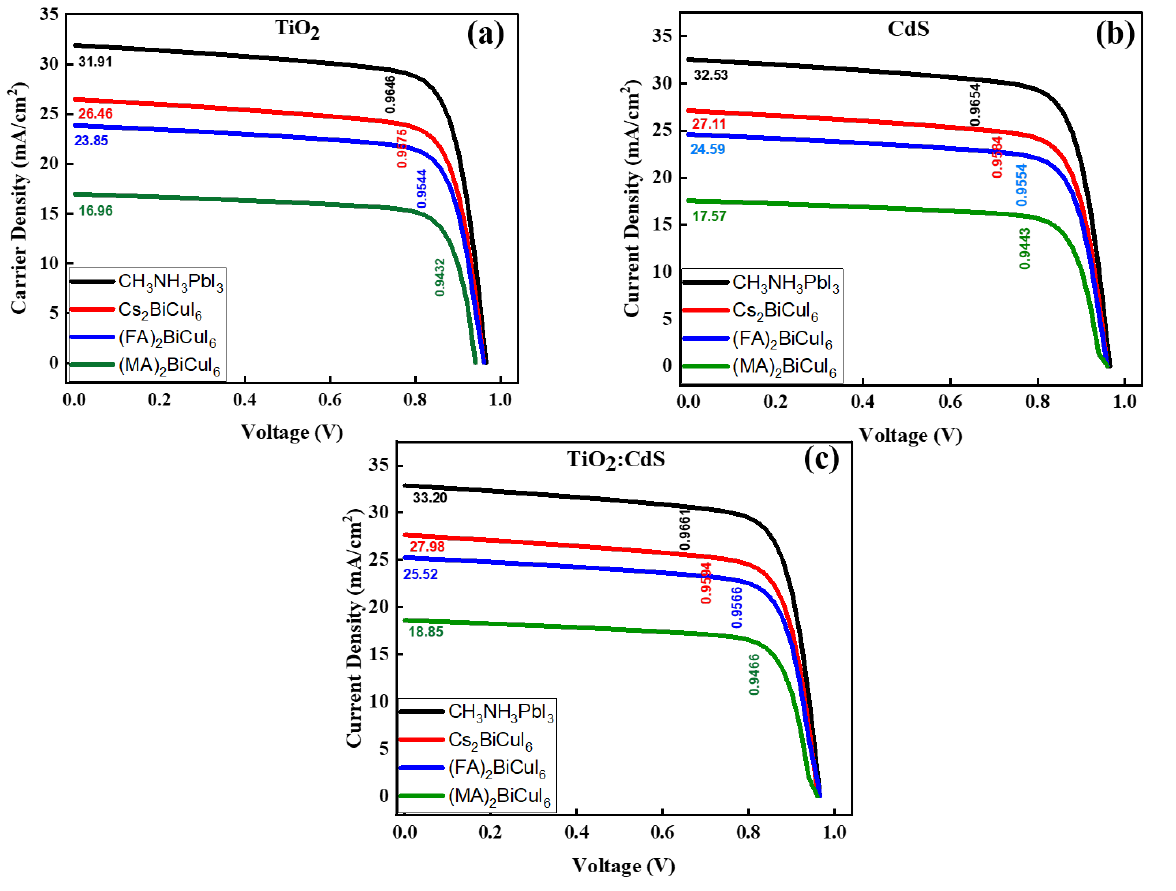
Figure 11. J – V Curve of different perovskite materials with ETM ( a ) TiO 2 , ( b ) CdS, and ( c ) TiO 2 :CdS. Table 3. Performance comparison of different ETMs and perovskite